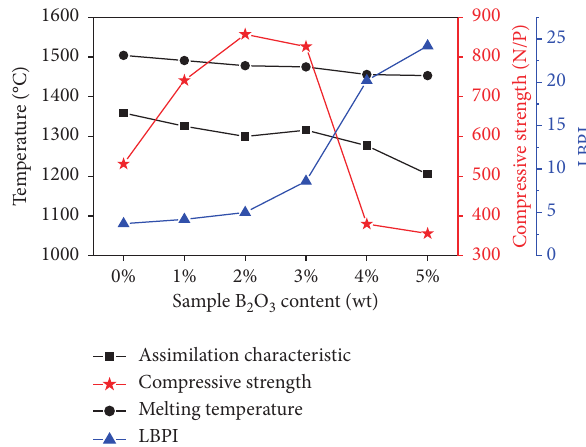
Figure 5: Sintering basic characteristics of the H-VTM sintered sample with different B